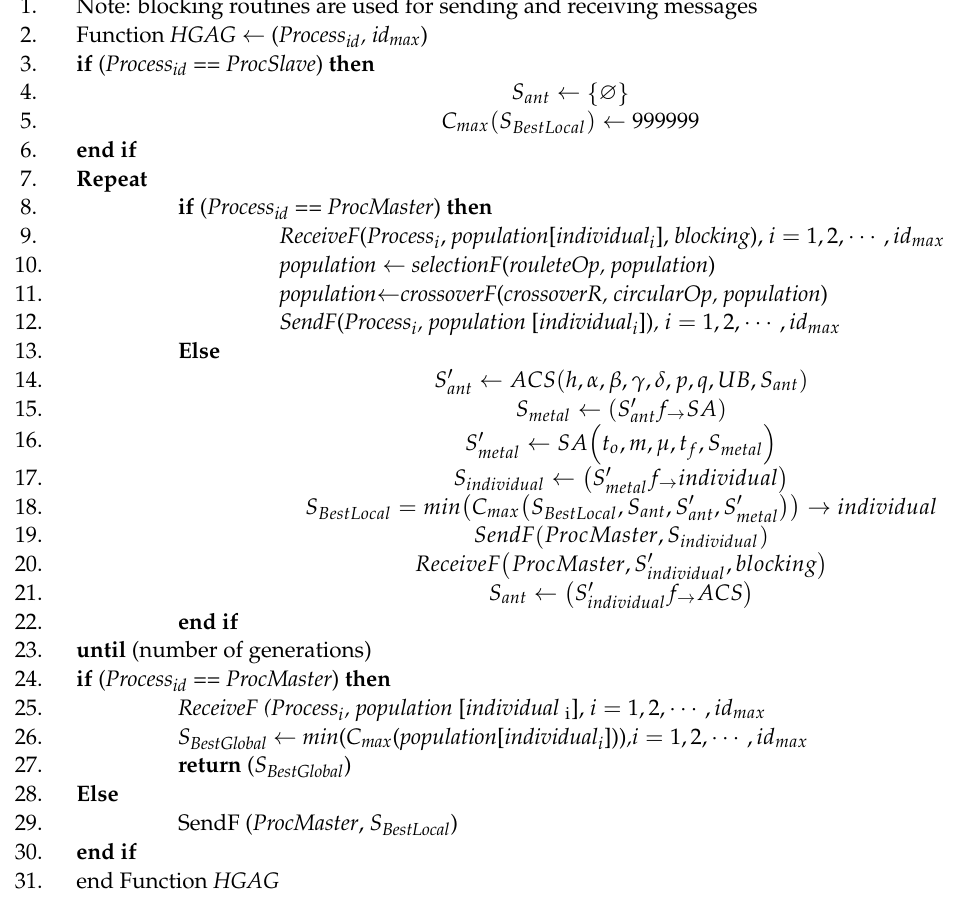
Algorithm 1 Hybrid Genetic Algorithm in Grid Environment